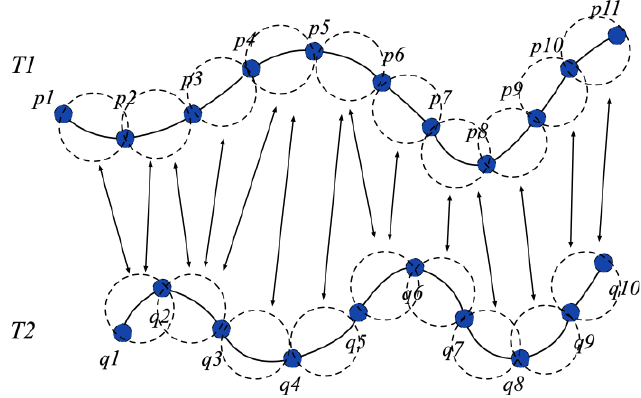
Figure 8. Schematic diagram of dynamic matching of segmented DTW algorithm.